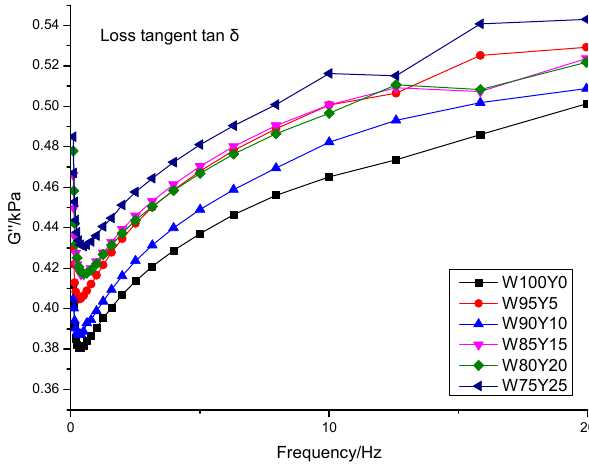
Figure 1. Frequency sweep data for wheat dough with different yam contents.